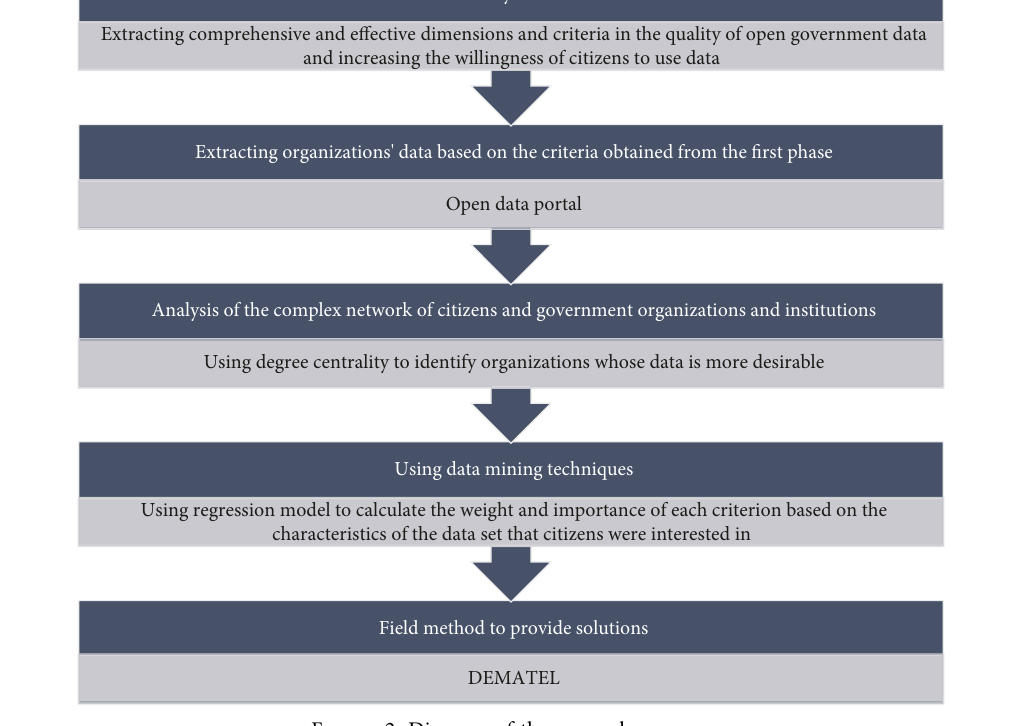
Figure 2: Diagram of the research process.